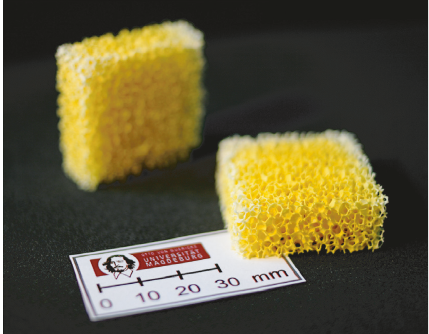
Figure 1: Open-cellular zinc oxide ceramic foams with a pore count of 20 ppi and 93.6% total porosity after sintering at 1100 ° C. The yellow color is a consequence of structural defects in the ZnO lattice (oxide vacancies and interstitial zinc